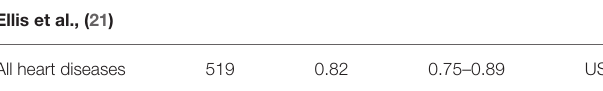
TABLE 10 | US TiO 2 workers at DuPont plants. Ellis et al.,